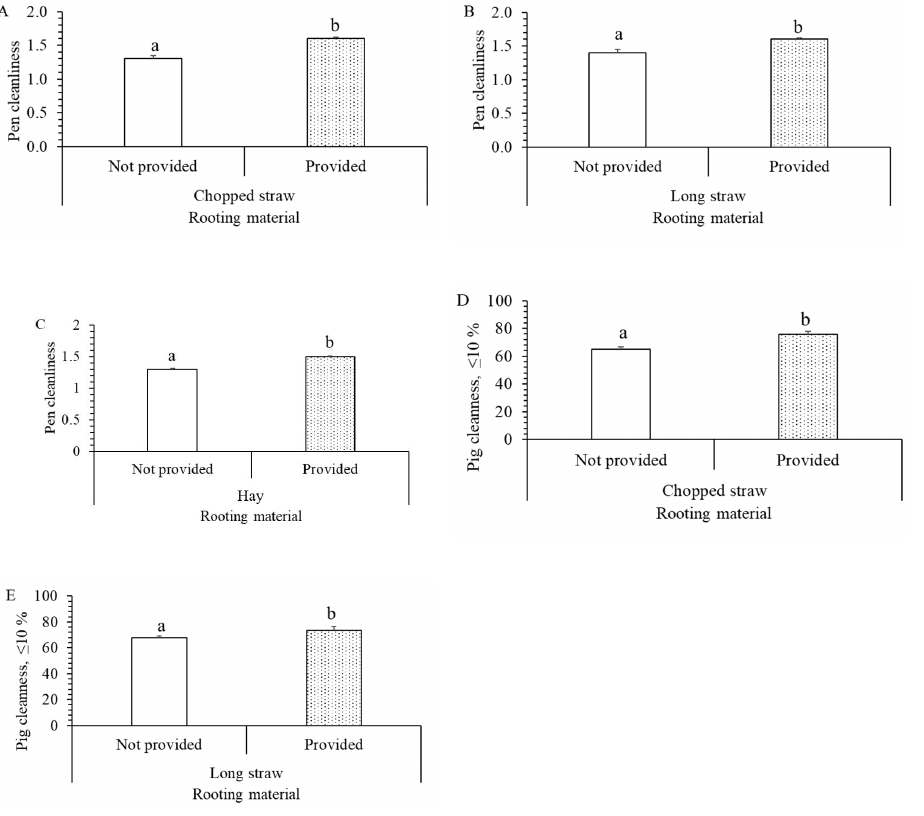
Figure 4. Effect of different rooting materials on pen, pig cleanliness and ammonia concentration. ( A ) Pen cleanliness and chopped straw (F 1,472 = 5.8; p =0.017). ( B ) Pen cleanliness and long straw (F 1,472